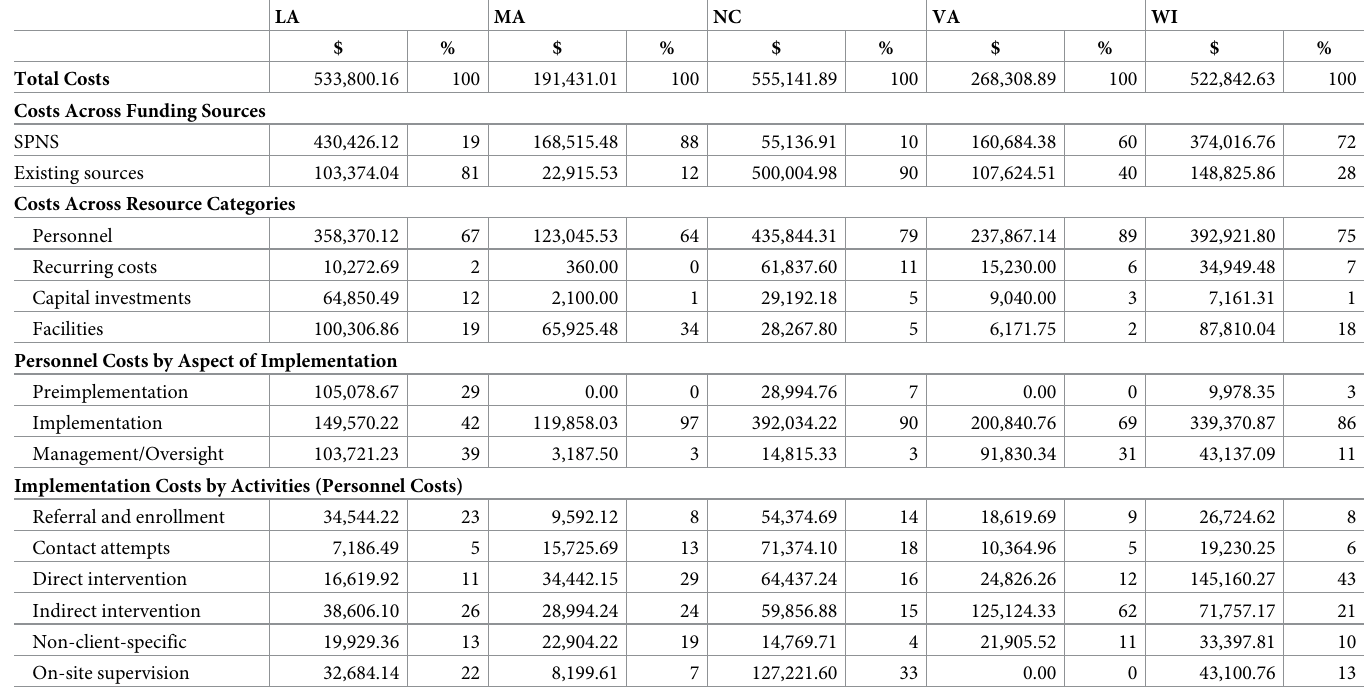
Table 3. Patient navigation interventions: Costs across funding sources, resource categories, aspects of implementation and implementation activities.